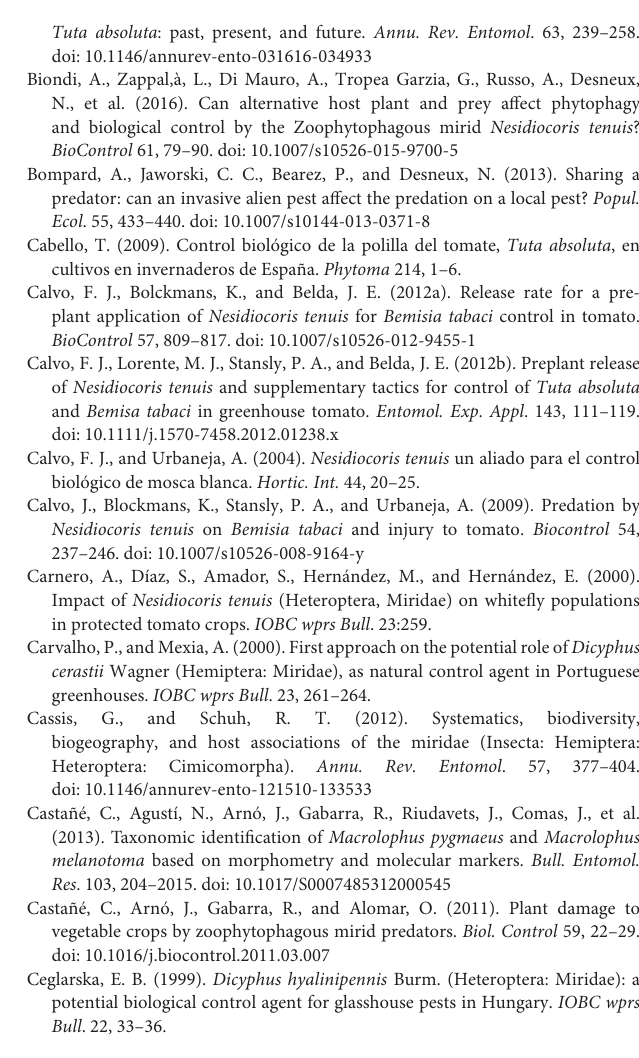
Macrolophus pygmaeus , injuries of Tuta absoluta and fruit